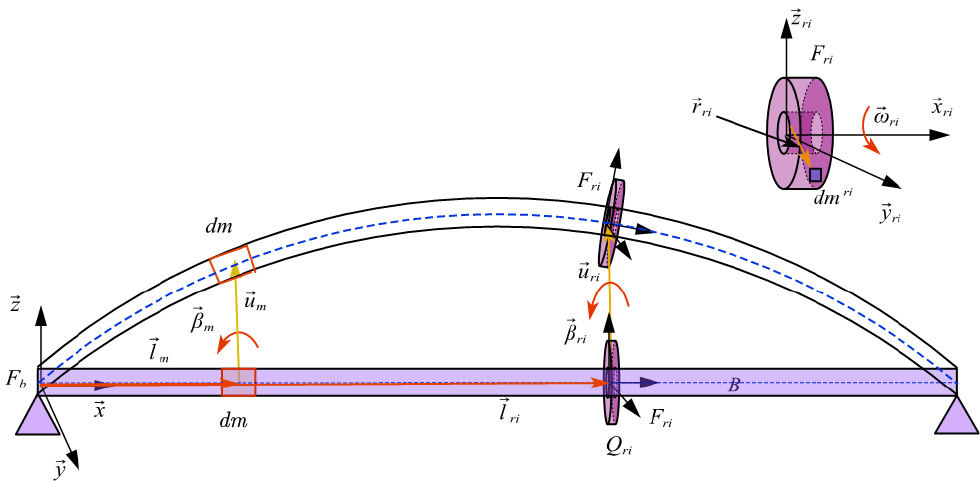
Figure 2. The displacements of the beam and the gyroscopes.